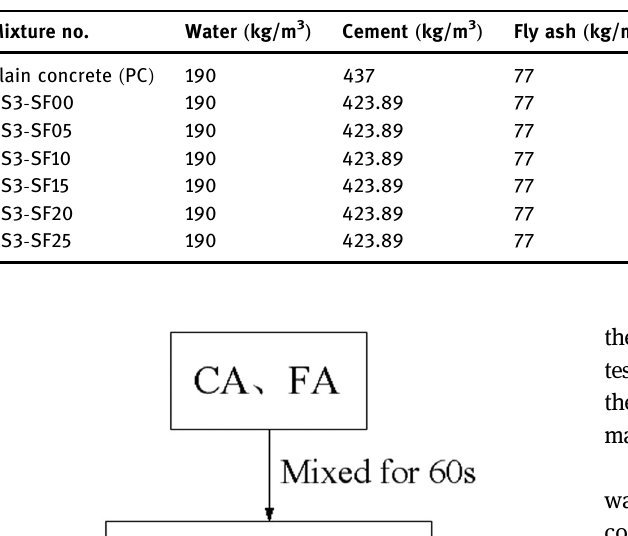
Table 5: Mix proportions of concrete specimens